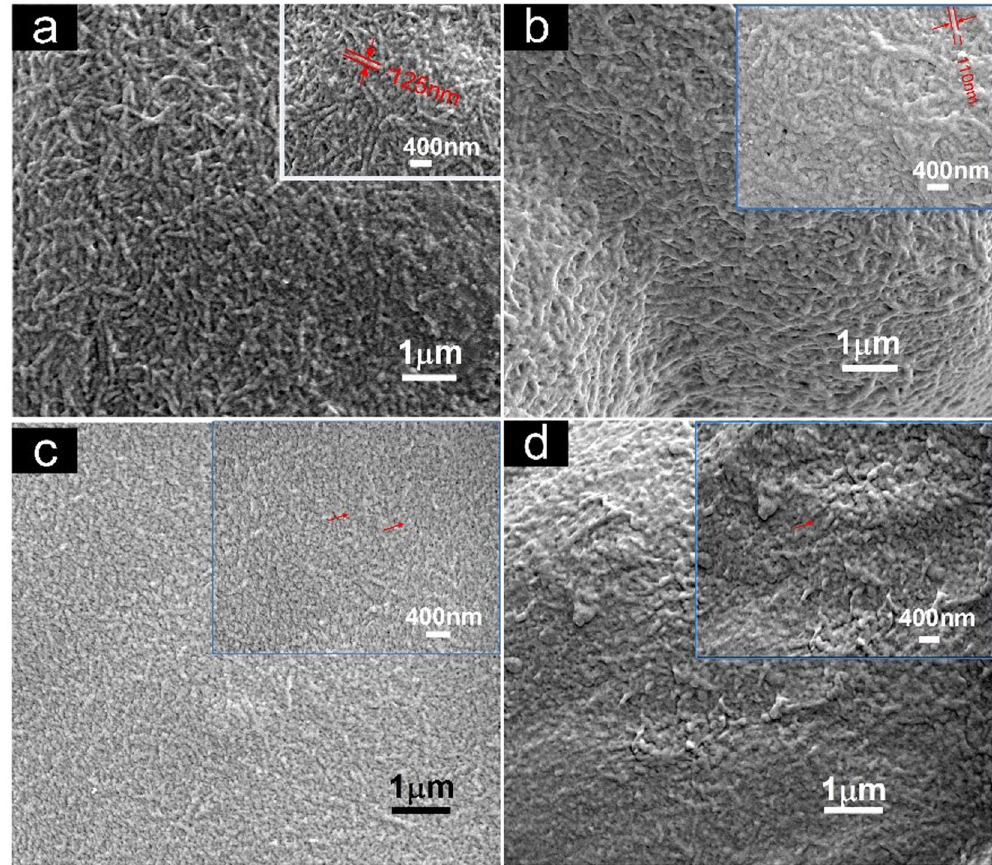
Figure 2. SEM images of evolution in the morphological structure of cellulose nanofibers after hot-pressing by 5 min ( a ), 10 min ( b ), 15 min ( c ) and 60 min ( d